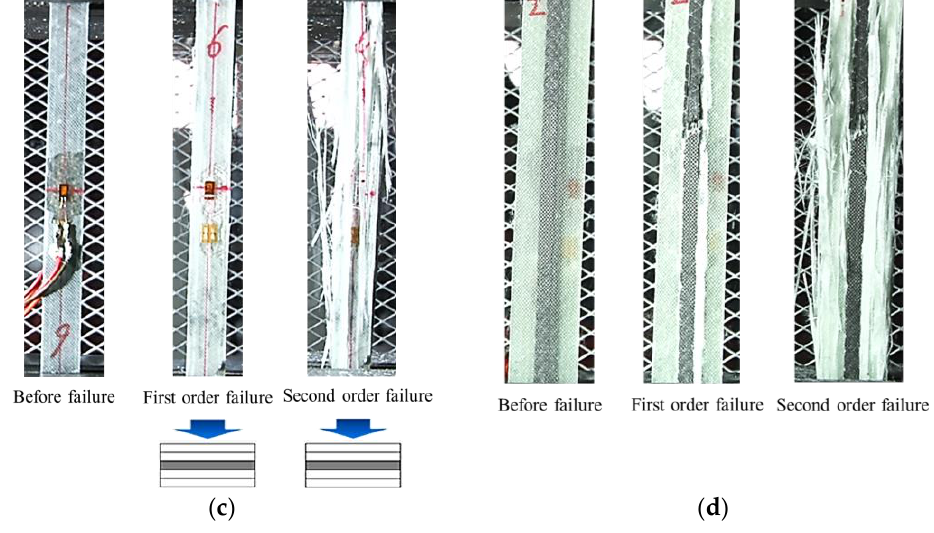
Figure 13. Failure process of hybrid composites: ( a ) [G/G/G/G/C]; ( b ) [G/G/G/C/G]; ( c ) [G/G/C/G/G]; ( d ) Intralayer composites [C/G/G/G/G]-0.5.